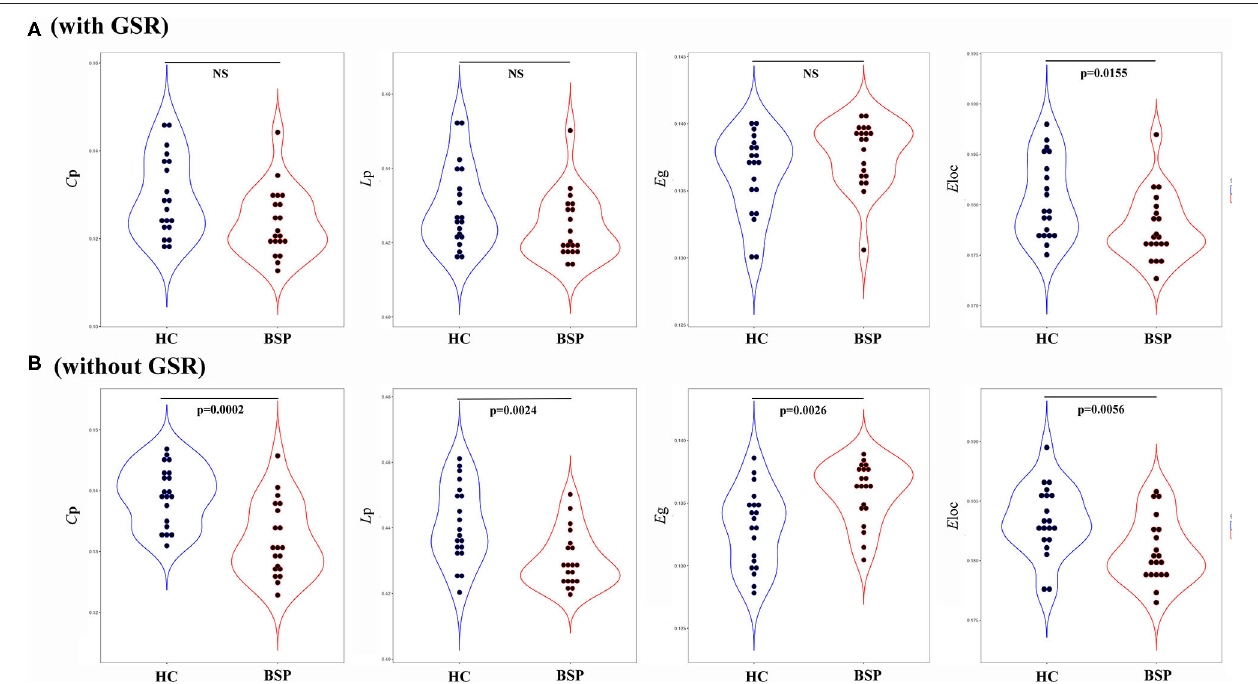
FIGURE 2 | (A) Inter-group differences in global topographic properties (with GSR); (B) inter-group differences in global topographic properties (without GSR). Values on the y -axis represent the AUC of the graph indices across the range of the sparsity threshold. AUC, area under the curve; BSP, blepharospasm; C p , clustering coefficient; E glob , global efficiency; E loc , local efficiency; HC, healthy control; L p , characteristic path